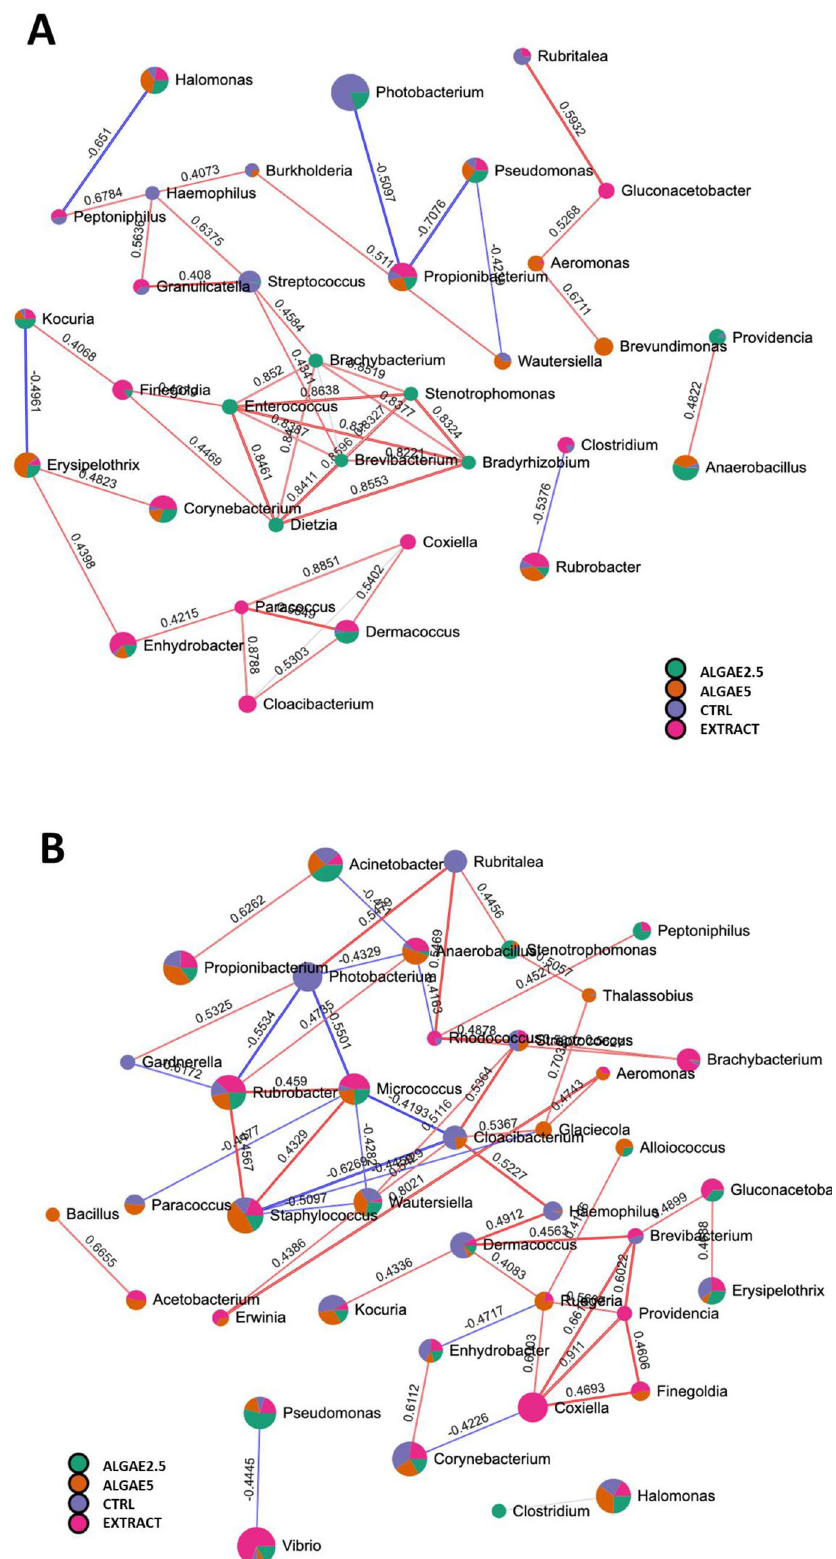
Figure 5. Correlation network analysis between microbial community of European seabass anterior ( A ) and posterior ( B ) intestine at genus level, on based on SparCC algorithm. Network nodes pie charts represent genus abundance per dietary group, and edges represent correlation between genera pairs where blue and red edges indicate negative and positive correlation respectively. Significant correlation threshold was set to 0.4 with P < 0.05. Fish were fed a basal diet with no supplement (CTRL) or supplemented with Gracilaria gracilis powdered biomass at 2.5% (ALGAE2.5), at 5% (ALGAE5) or with the seaweed extract at 0.35% inclusion rate